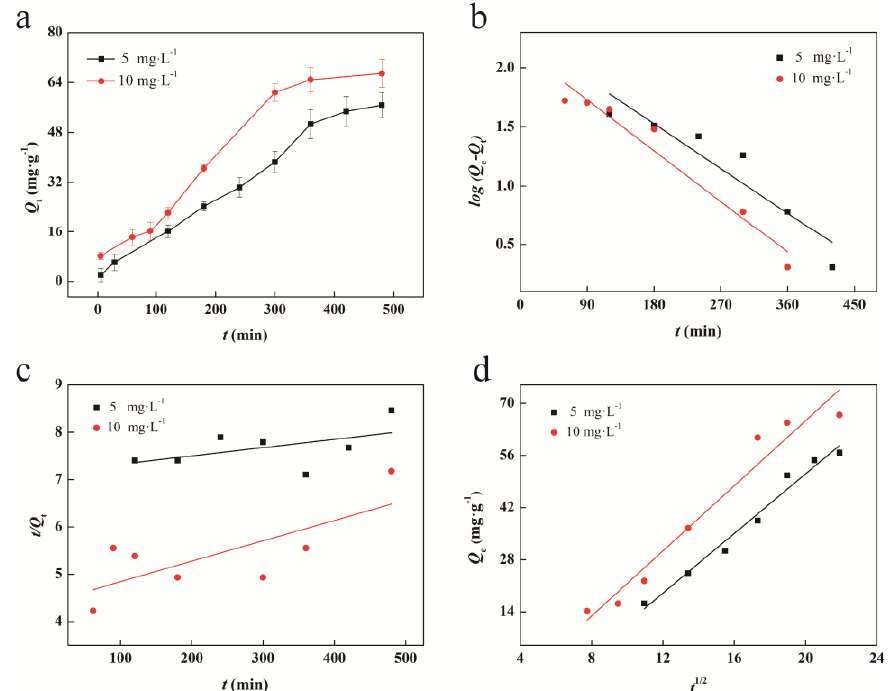
Figure 5. ( a ) Adsorption capacity with time of membrane at different concentrations; ( b ) Linear fitting of the pseudo − first − order model; ( c ) Linear fitting of the pseudo − second − order model; ( d ) Linear fitting of the intra-particle diffusion model. Table 3. Kinetic adsorption model parameters of Cu2+ by sandwich adsorptive membrane.